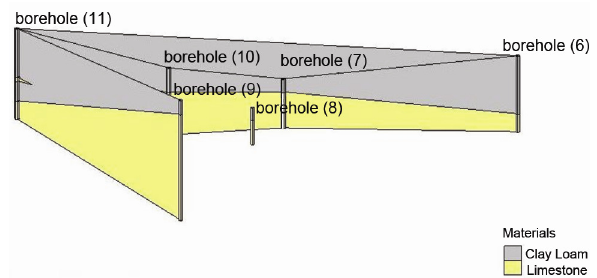
Fig. 2. Lithologic fan diagram of the study